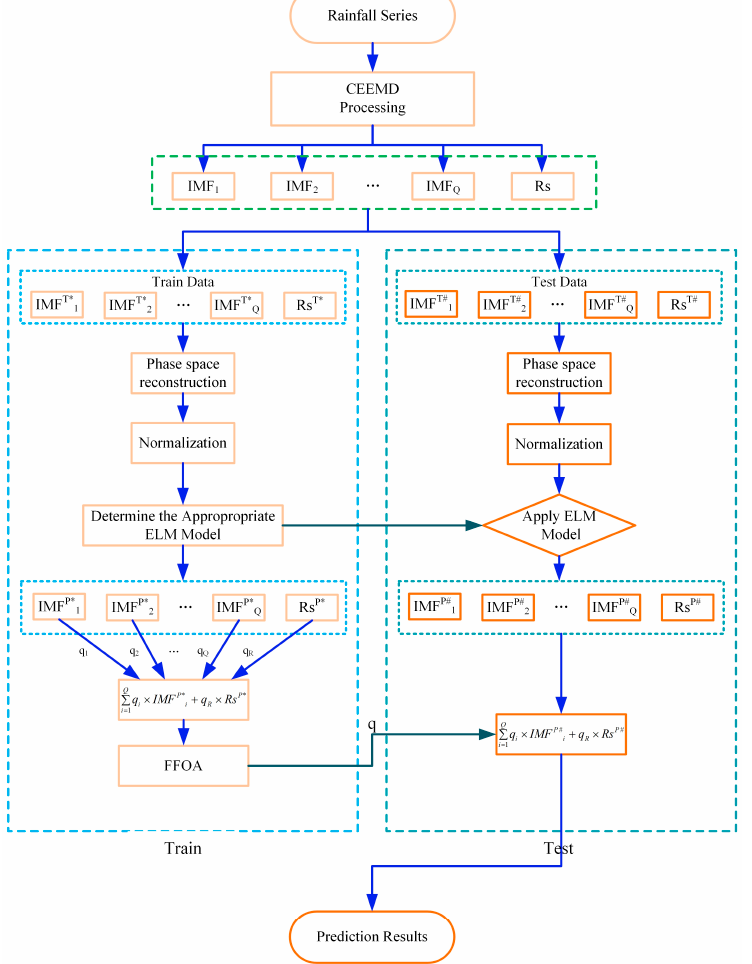
Figure 1. The technical route of the CEEMD-ELM-FFOA Coupling Prediction Model (* Marks training data and # marks test data).